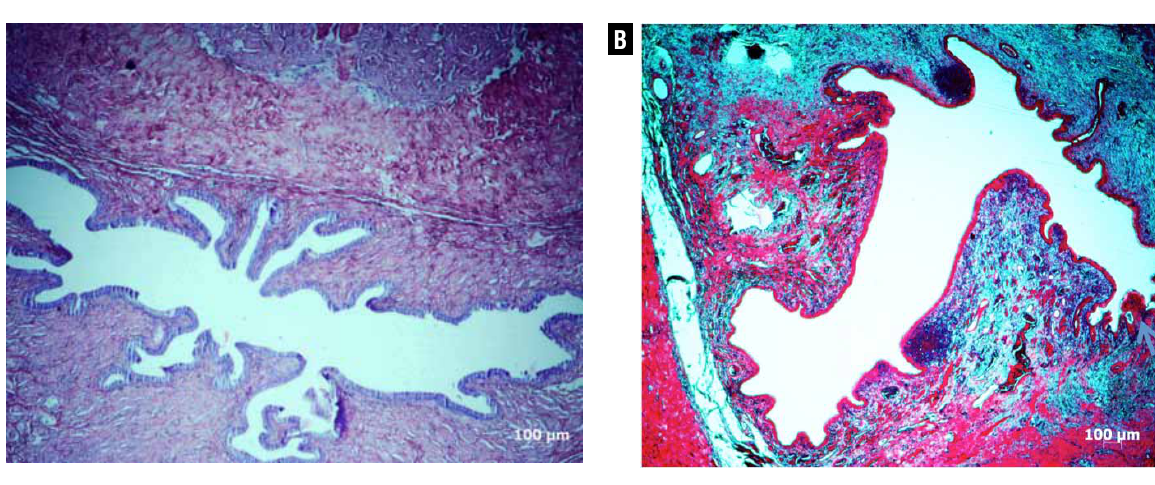
Figure 5 - A - Photomicrography of the urethra - Group I animal, postoperative day 28, H&E, 25x. B - Photomicrography of the urethra - Group II animal, postoperative day 28. Blue arrow = squamous metaplasia. Masson’s trichrome, 25x.